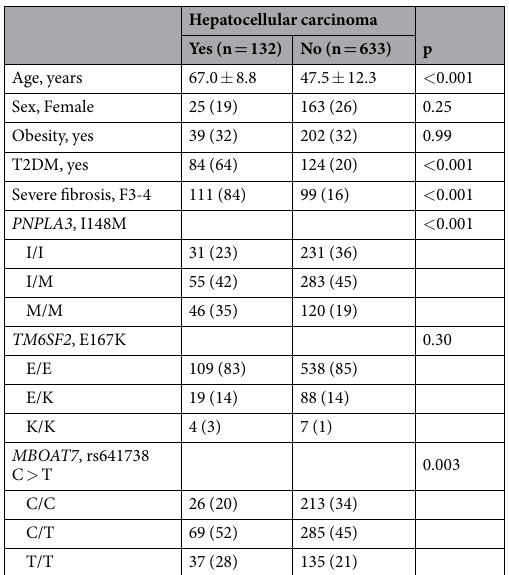
Table 1. Clinical features of 765 Italian NAFLD patients stratified by HCC diagnosis. (): % values; T2DM: type 2 diabetes mellitus. Comparisons were performed by logistic regression setting HCC as dependent variable, and the association of genetic variants was analyzed assuming additive